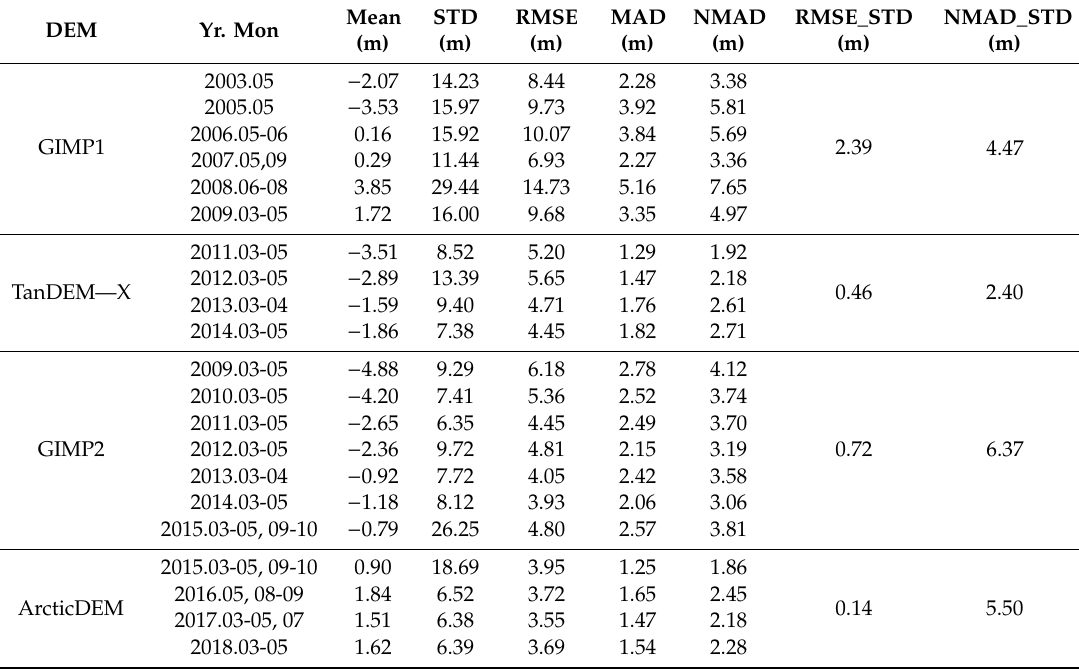
Table 9. Analysis of the interannual changes in the four